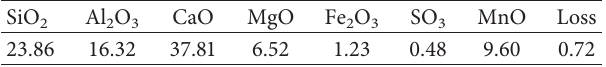
Table 1: The main components of EMR